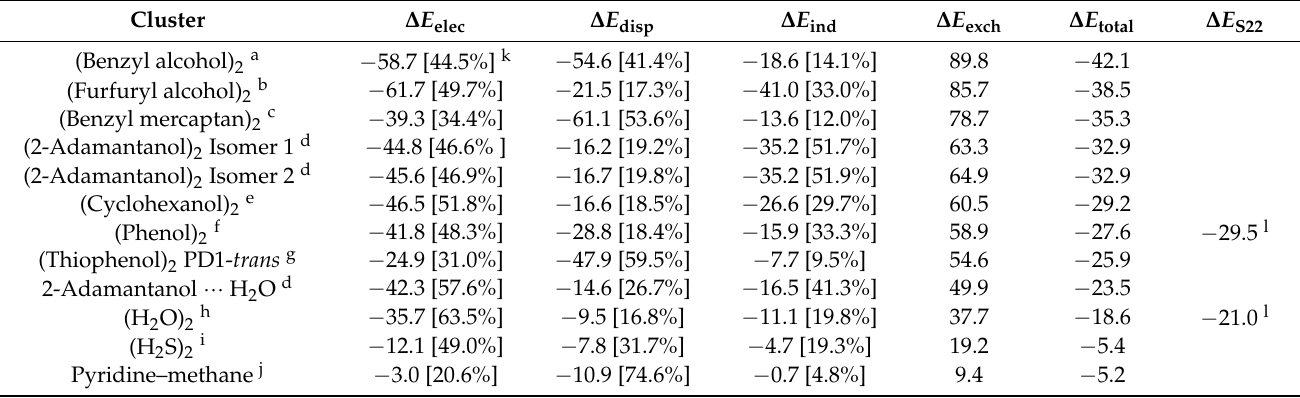
Relative percentage contribution to the attractive interactions ( ∆ E elec + ∆ E disp + ∆ E ind ). l Ref. [64]. Non-covalent interactions were also analysed using the Johnson–Contreras NCIPlot topological analysis of the electron density ( ρ ( r ) ) [49], based on the reduced electronic . Figure 5 contains a representation of the reduced gradient ( s ) versus the signed electronic density ( sign ( λ 2 ) ρ ) using the second eigenvalue ( λ ) of the electron density Hessian, together with a spatial mapping of the non-covalent 2 interactions in the title compounds (using a blue–green–red color code). Figure 5 identifies the primary O-H ··· O hydrogen bond interactions in the alcohols (blue surfaces along the O-H ··· O directions), simultaneously suggesting additional regions with minor interactions (green shades). As an example, intramolecular interactions caused by the lone pairs of the oxygen atom are apparent in the Figure, both in the dimer and the monohydrate. At the same time, intermolecular interactions are suggested for the monohydrate similarly involving the water oxygen lone pair and the C-H groups of 2-adamantanol. In the 2-adamantanol dimer, weak intermolecular interactions between the two aliphatic side chains are revealed, qualitatively attributing some attractive role to both sidechains on dimerization. Intramolecular repulsive regions (mostly inside the rings) are marked by red shades. The representation of the signed reduced electronic density gradient also compares the strength of the NCI in the monohydrate and the dimer, observing a close correspondence between the main O-H ··· O interactions in both dimers (most negative minima in the s vs ρ Figure). The reduced electronic density calculations thus complement the structural and energetic description of the 2-adamantanol dimers in Tables